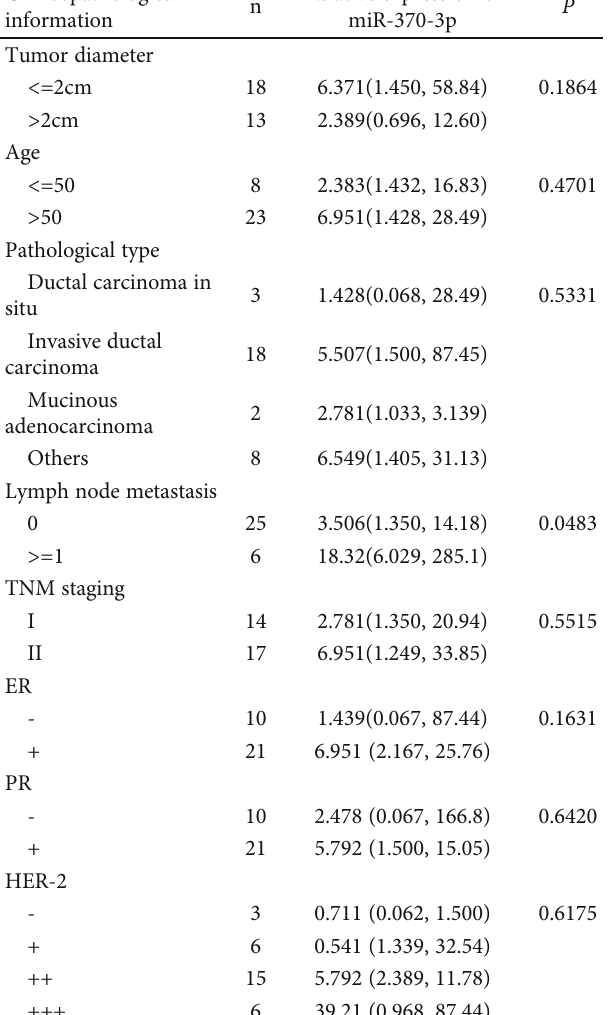
Table 2: Correlation between miR-370-3p in breast cancer tissues and clinicopathological parameters.